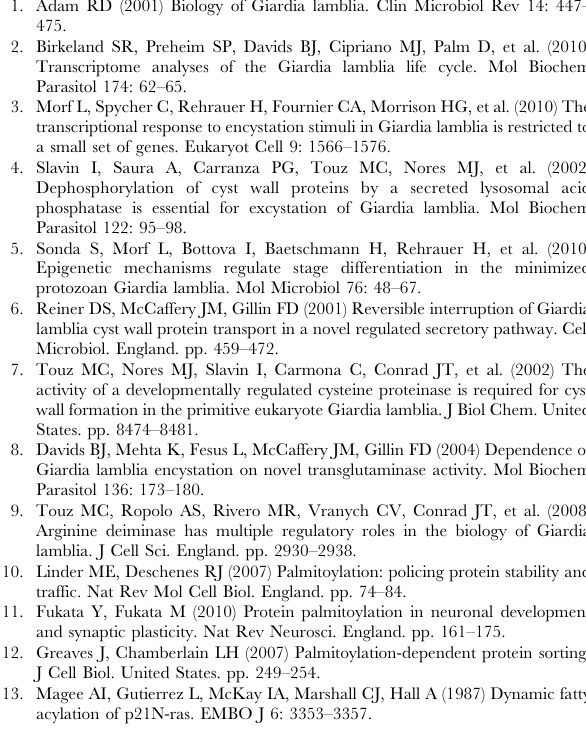
Table S1 Oligonucleotide primers used for Giardia DHHC cloning. Table S2 Oligonucleotide primers used for semiquan- titative RT-PCR. Table S3 Oligonucleotide primers used for